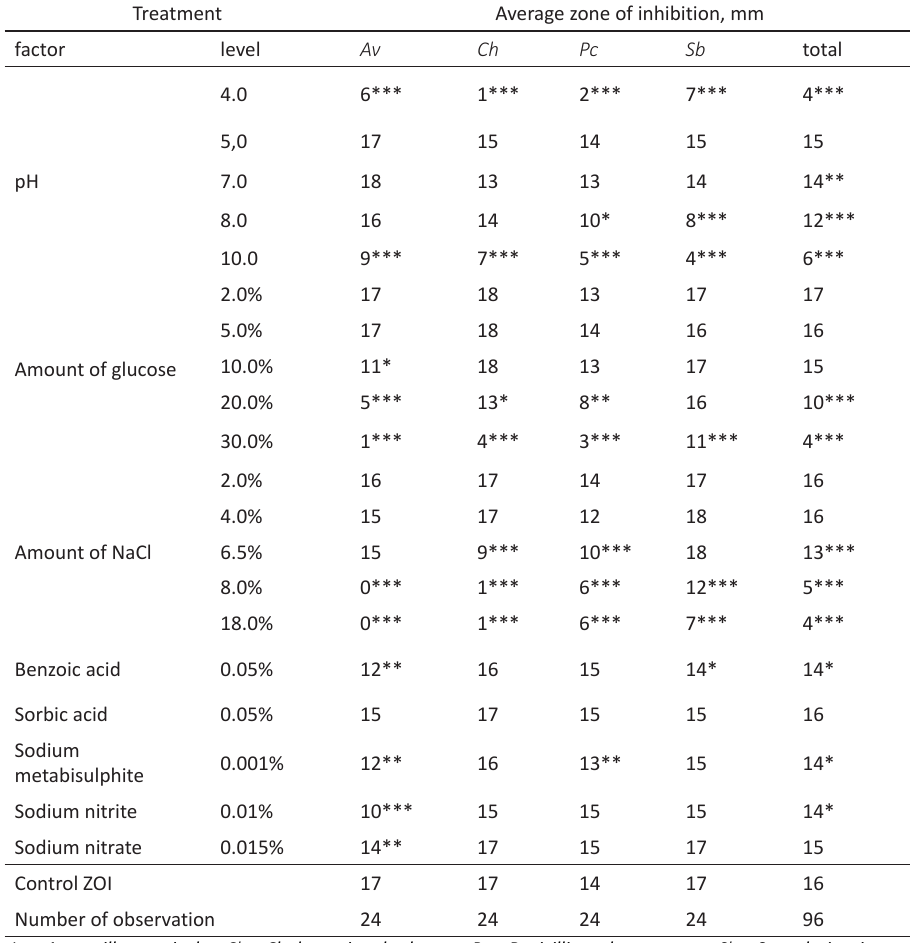
Table 4. Average zones of inhibition and statistical significance of the treatment effect on antifungal activity of the analyzed LAB strains Treatment Average zone of inhibition,